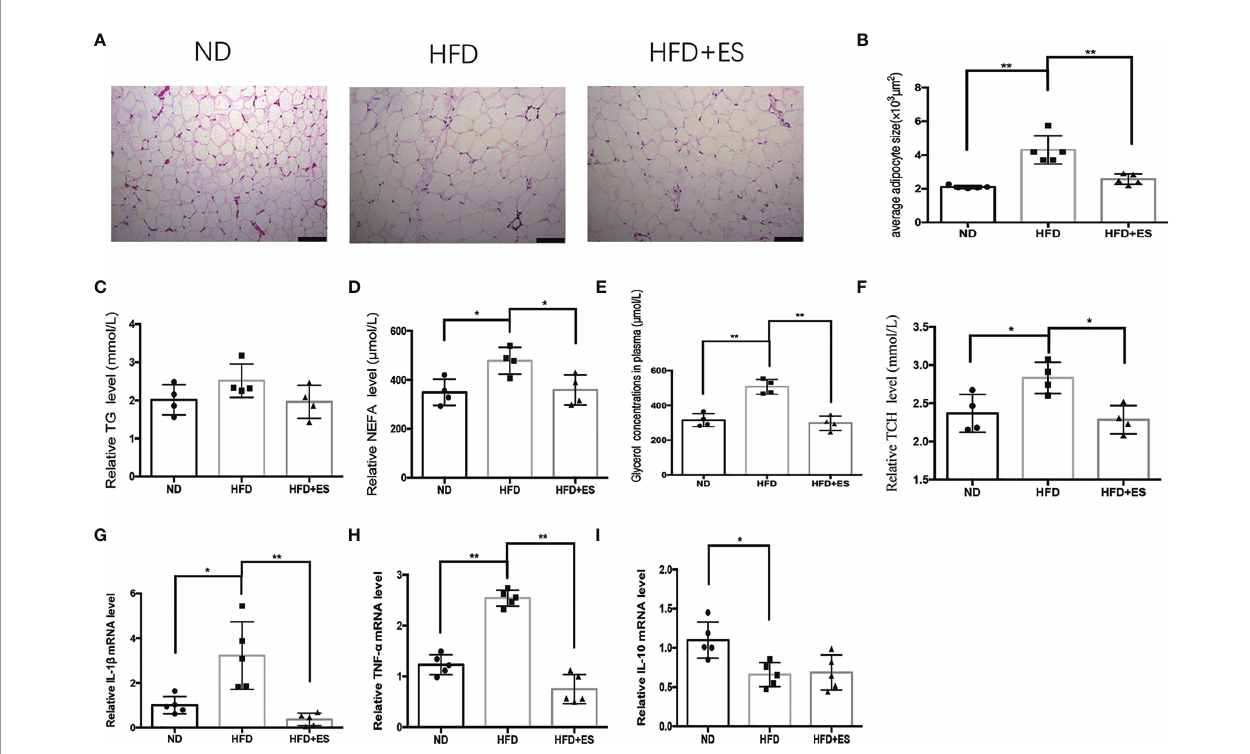
FIGURE 2 | ES attenuated adiposein fl ammation and dyslipidemia. (A) Representative hematoxylinand eosin (H&E) staining sections(scale bar, 100 m m). (B) Adipocyte size ineWAT fromthe ND,HFD,and HFD+ES groups was measured (n= 5, ** P <0.01). (C) Serum levelsof triglyceride (TG) inthe ND, HFD, and HFD+ES groups (n= 4). (D) Serum levels of non-esteri fi edfatty acid (NEFA) inthe ND, HFD, and HFD+ES groups(n = 4, * P < 0.05). (E) Serum levelsof glycerol inthe ND, HFD, and HFD+ES groups (n = 4, ** P < 0.01). (F) Serum levelsof total cholesterol (TCH)in the ND,HFD, andHFD + ES groups (n= 4, * P <. 05). (G) Relative IL-1 b mRNA expression ineWAT (n = 5, * P < 0.05, ** P < 0.01). (H) Relative TNF- a mRNA expression in eWAT (n= 5, ** P < 0.01). (I) Relative IL-10 mRNA expression in eWAT (n = 5, * P <